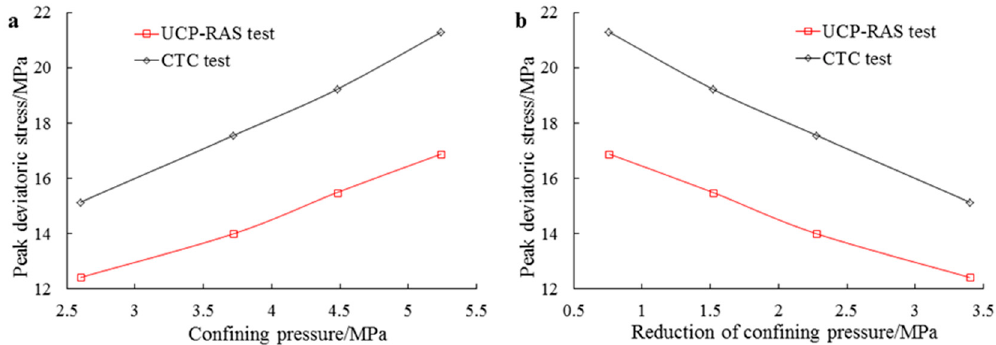
Figure 10. Unloading confining pressure damaging the peak strength of coal for UCP-RAS and CTC tests. ( a ) Peak deviatoric stress vs. current confining pressure; ( b ) peak deviatoric stress vs. reduction of confining pressure.